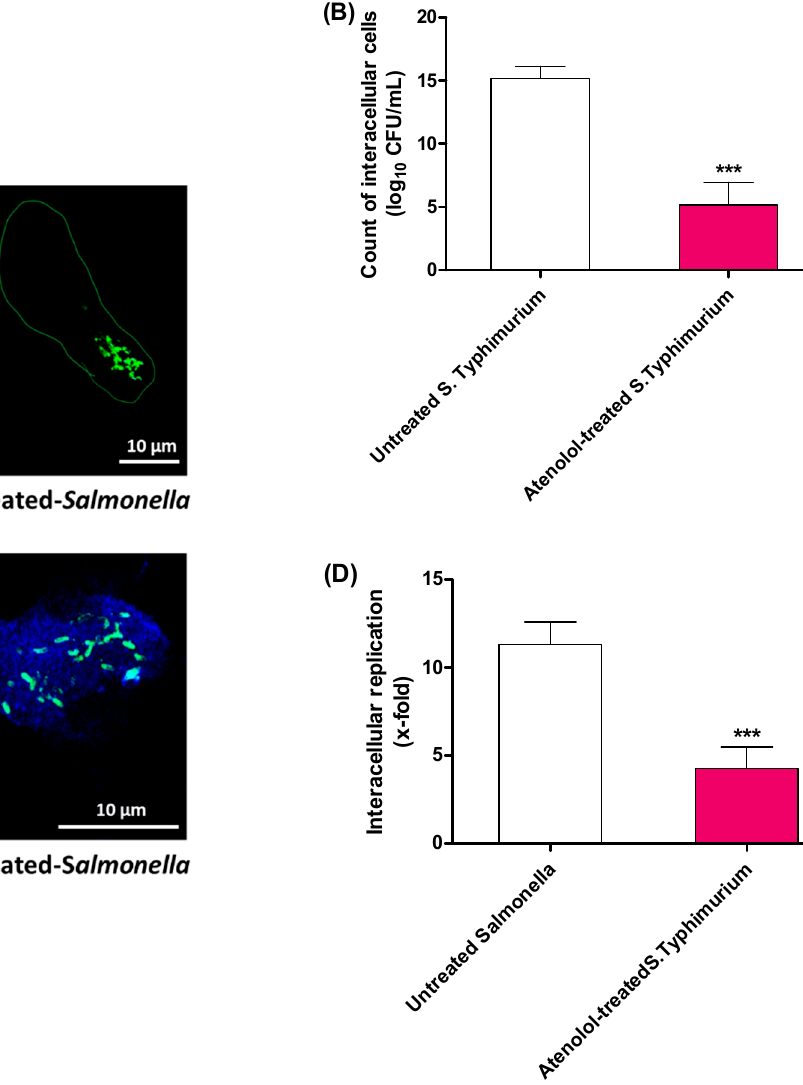
Figure 3. Effect of atenolol at sub-MIC on S. typhimurium invasion and intracellular replication. ( A ) A representative fluorescent microscopic image shows the obvious mitigation of the S. typhimurium invasion to HeLa cells in the presence of atenolol. ( B ) The viable count of the invading S. typhimurium to HeLa cells in the presence and absence of atenolol. Atenolol significantly attenuated S. typhimurium , and the numbers of invading cells significantly decreased. ( C ) A representative fluorescent microscopic image shows the marked diminishing of the intracellularly replicating S. typhimurium in raw macrophages in the presence of atenolol. ( D ) The intracellular replicating S. typhimurium counted against the initial invading bacterial cells and the fold changes were calculated. Atenolol significantly decreased the intracellular replication of S. typhimurium (*** p < 0.0001). The experiment was performed in triplicate and results are expressed as the means ± standard deviation with p value < 0.05 considered statistically significant.